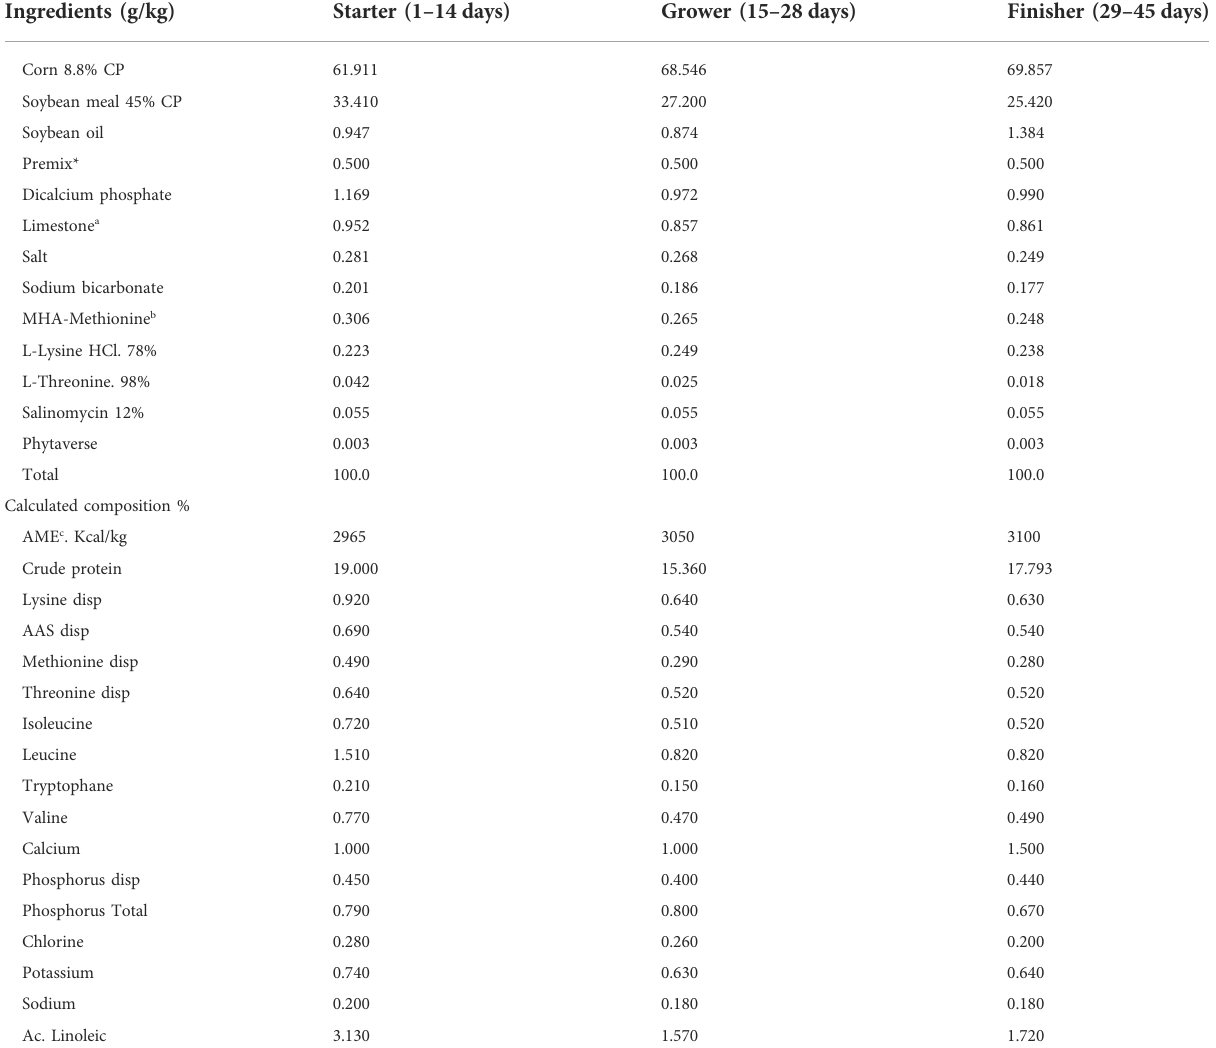
TABLE 3 Composition of the basal diet for all stages of development of progeny